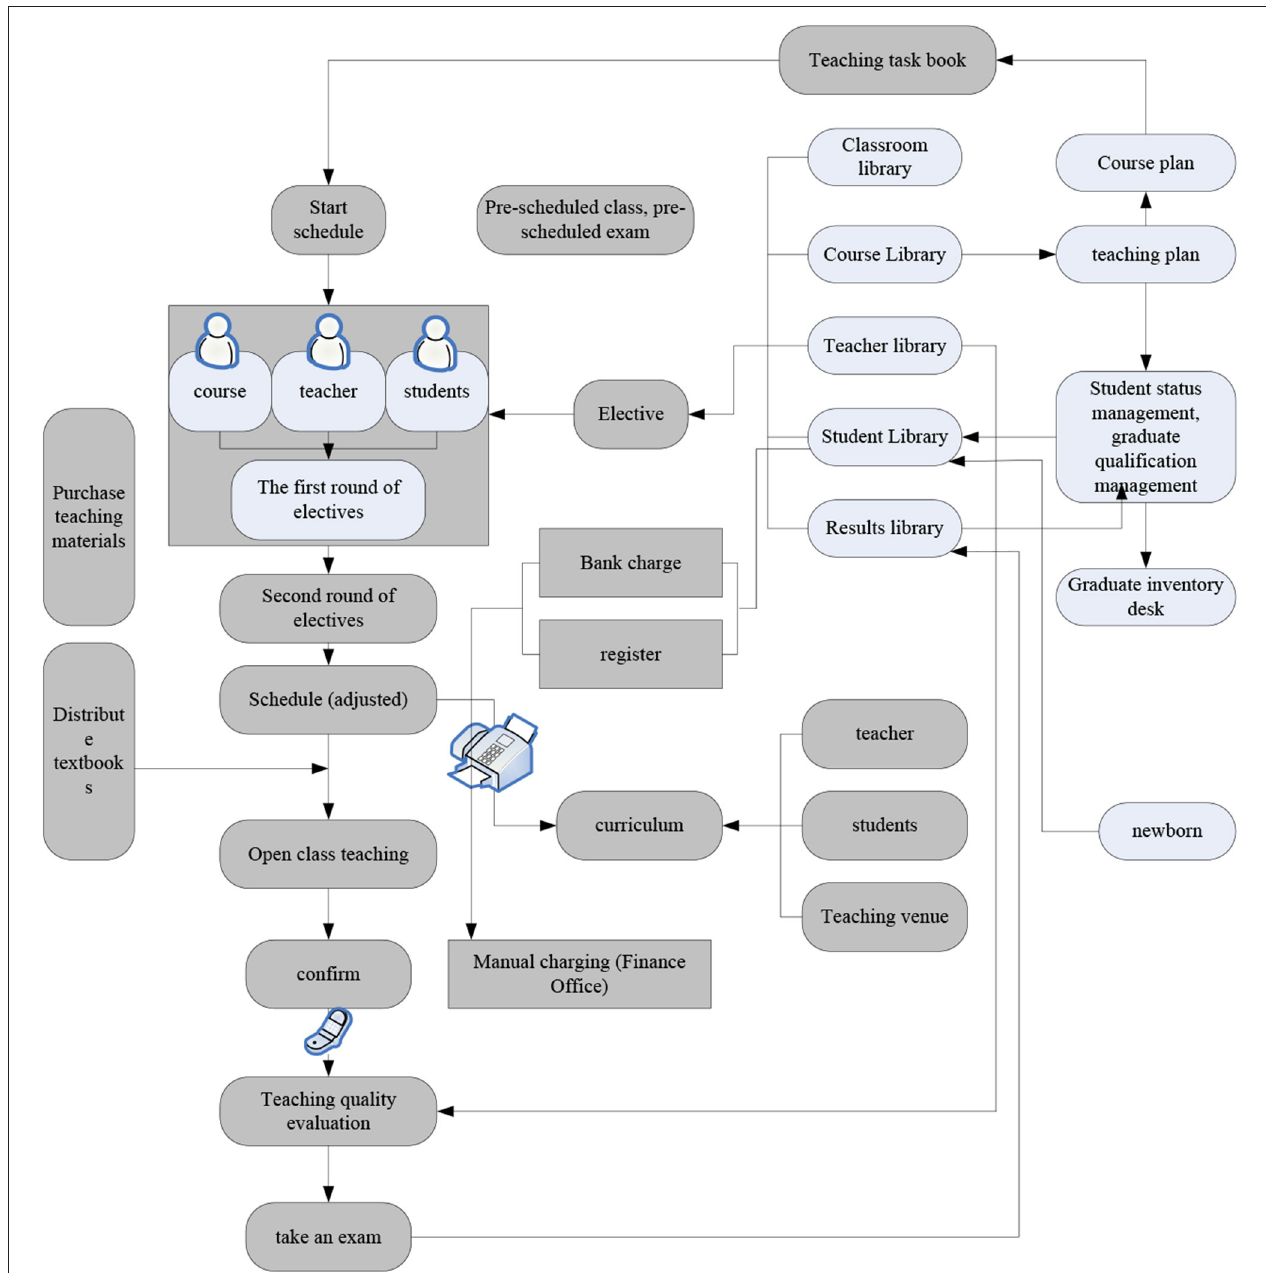
FIGURE 2 | Academic Management System flow data and the module